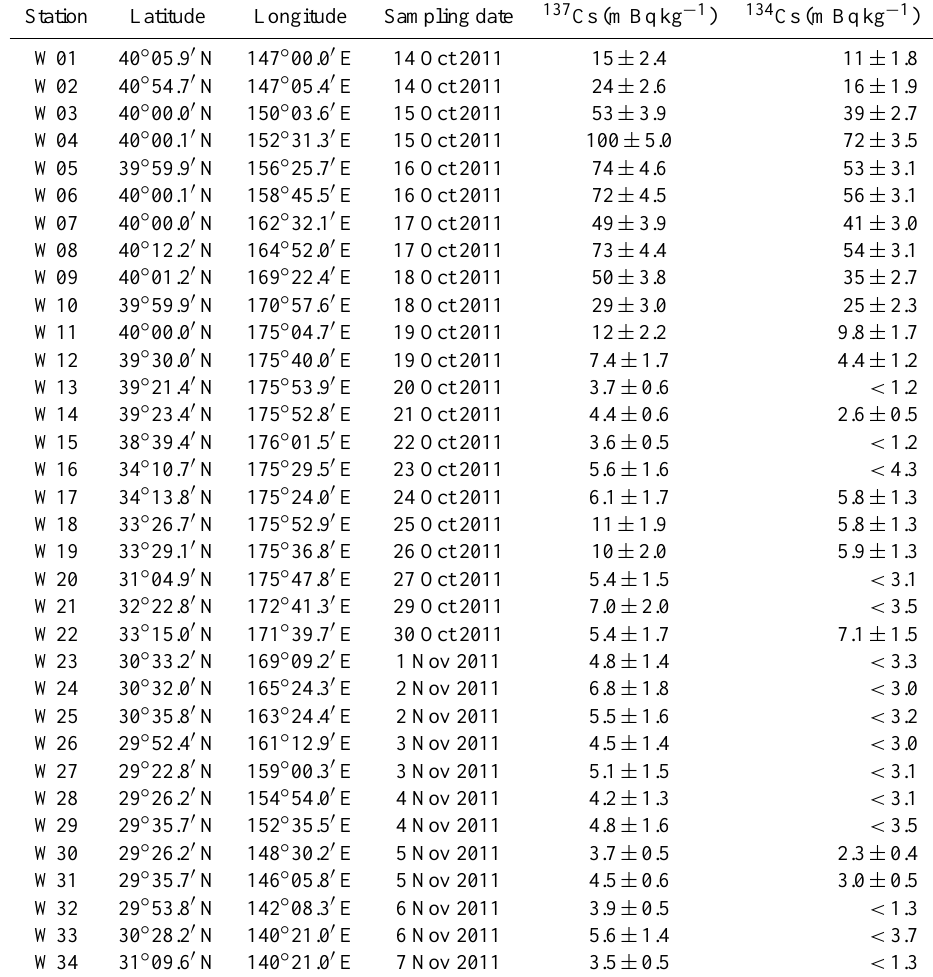
Table 2. Concentrations of 134 Cs and 137 Cs in the surface seawater collected during 14 October and 7 November 2011. Station Latitude Longitude Sampling